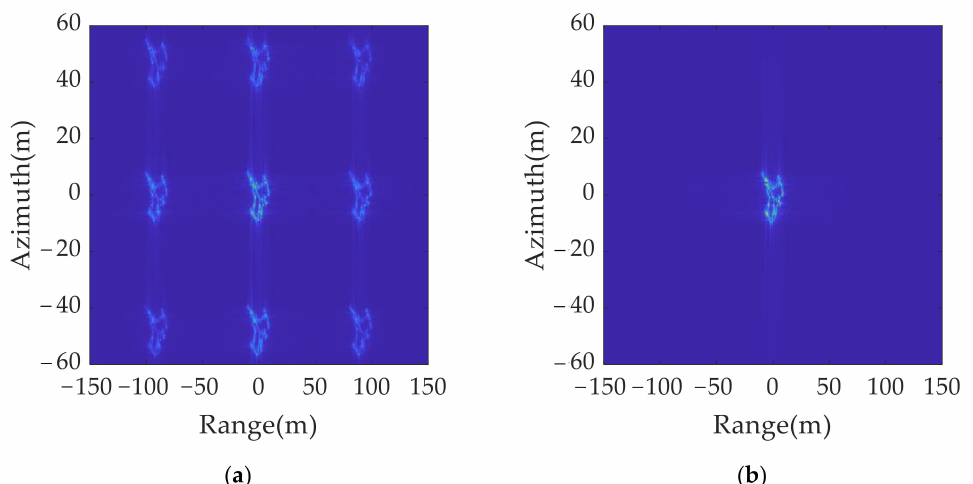
Figure 16. 2D deception anti-jamming results: ( a ) anti-jamming results without eliminating sidelobe; ( b ) anti-jamming results after eliminating sidelobe and spatial position mapping.